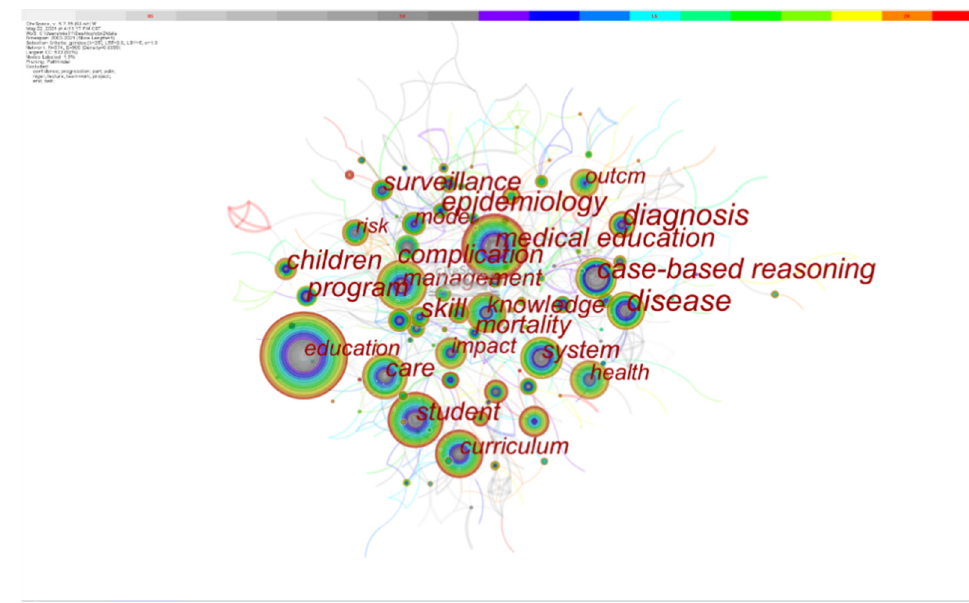
Figure 4. Keyword co-occurrence